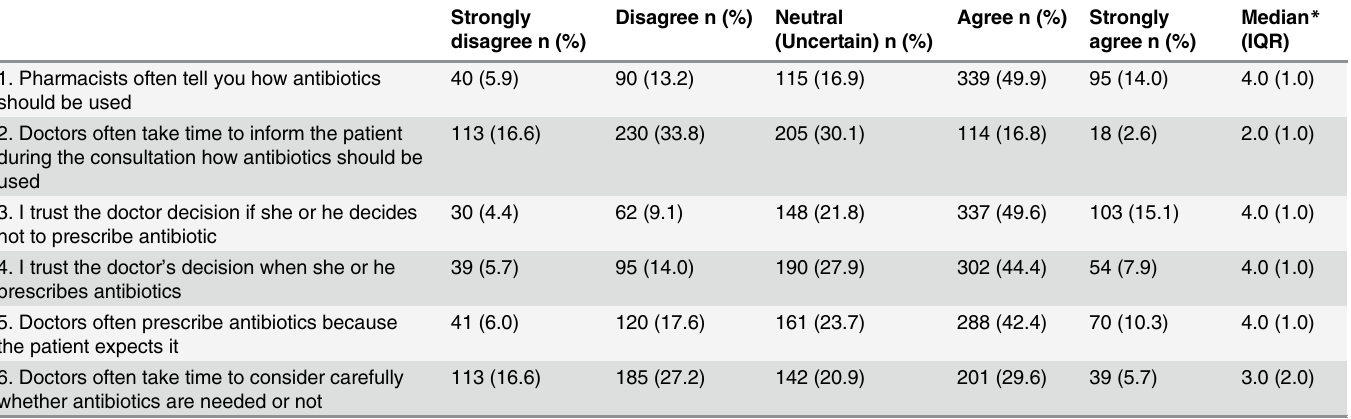
Table 4. Doctor ’ s habit and the patient/doctor relationship (n =